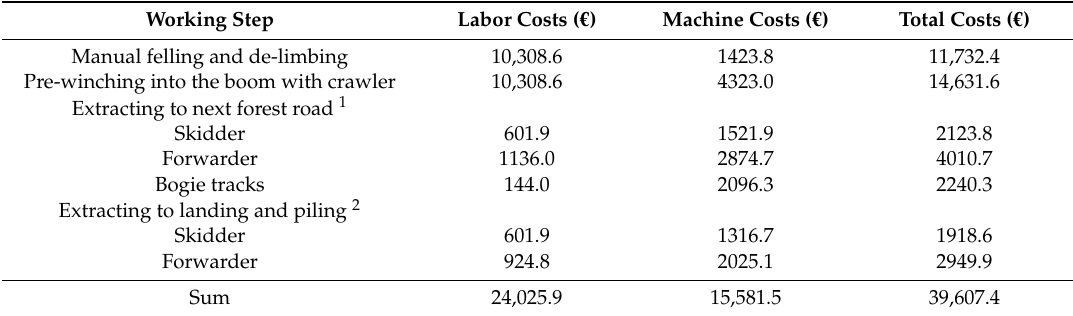
Table 9. Resulting labor, machine, and total costs of the di ff erent working steps in the ground-based FO, in €